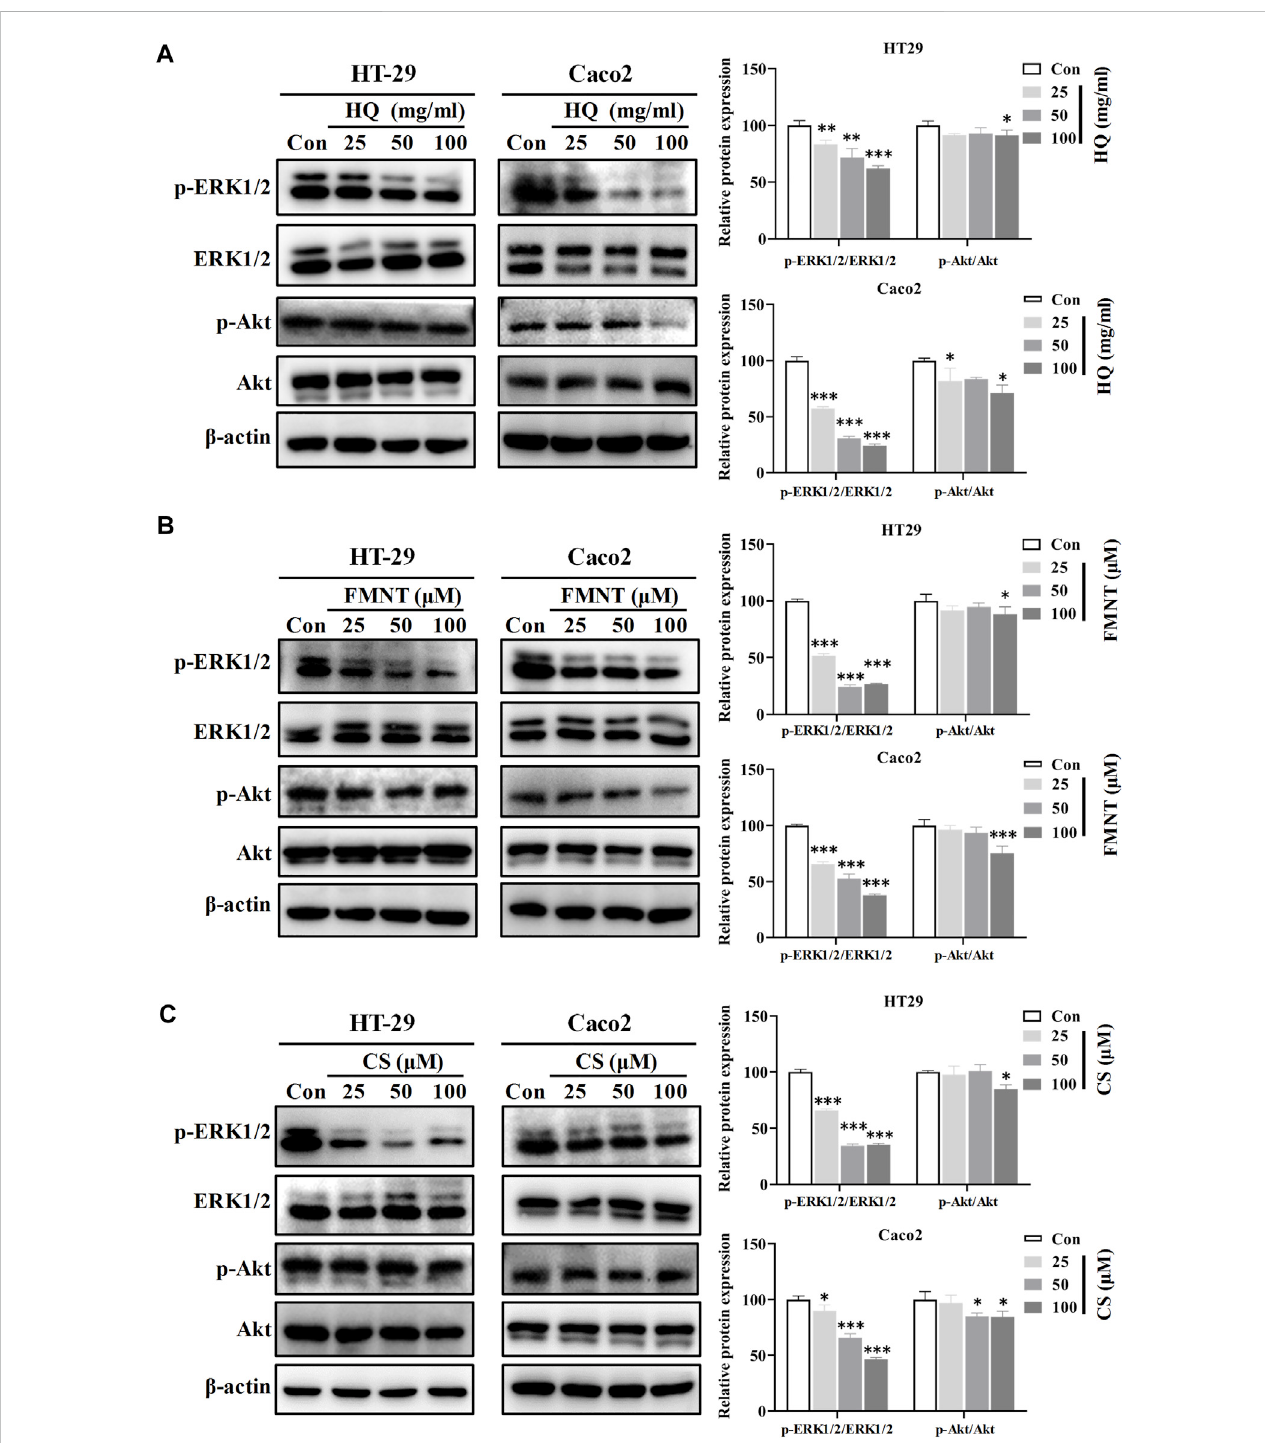
FIGURE 11 HQ,FMNTandCSsigni fi cantlyinhibitedtheERK1/2andPI3K-AKTsignalingpathways.Theproteinlevelsofp-Erk1/2,ERK1/2,p-AKTandAKTinHT29and Caco2 cells were detected after treatment with HQ (25, 50 and 100 mg/mL, 48 h) (A) , FMNT (25, 50 and 100 μ M, 48 h) (B) or CS (25, 50 and 100 μ M, 48 h) (C) , respectively. The data represent the mean ± SD (n = 3). * p < 0.05, ** p < 0.01 and *** p < 0.001 compared with the control